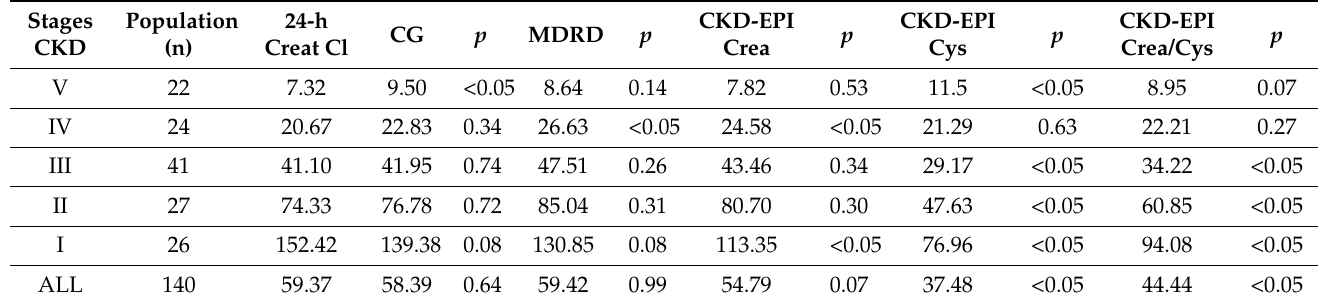
Table 2. Comparison of CrCl and eGFR by method (mL/min).